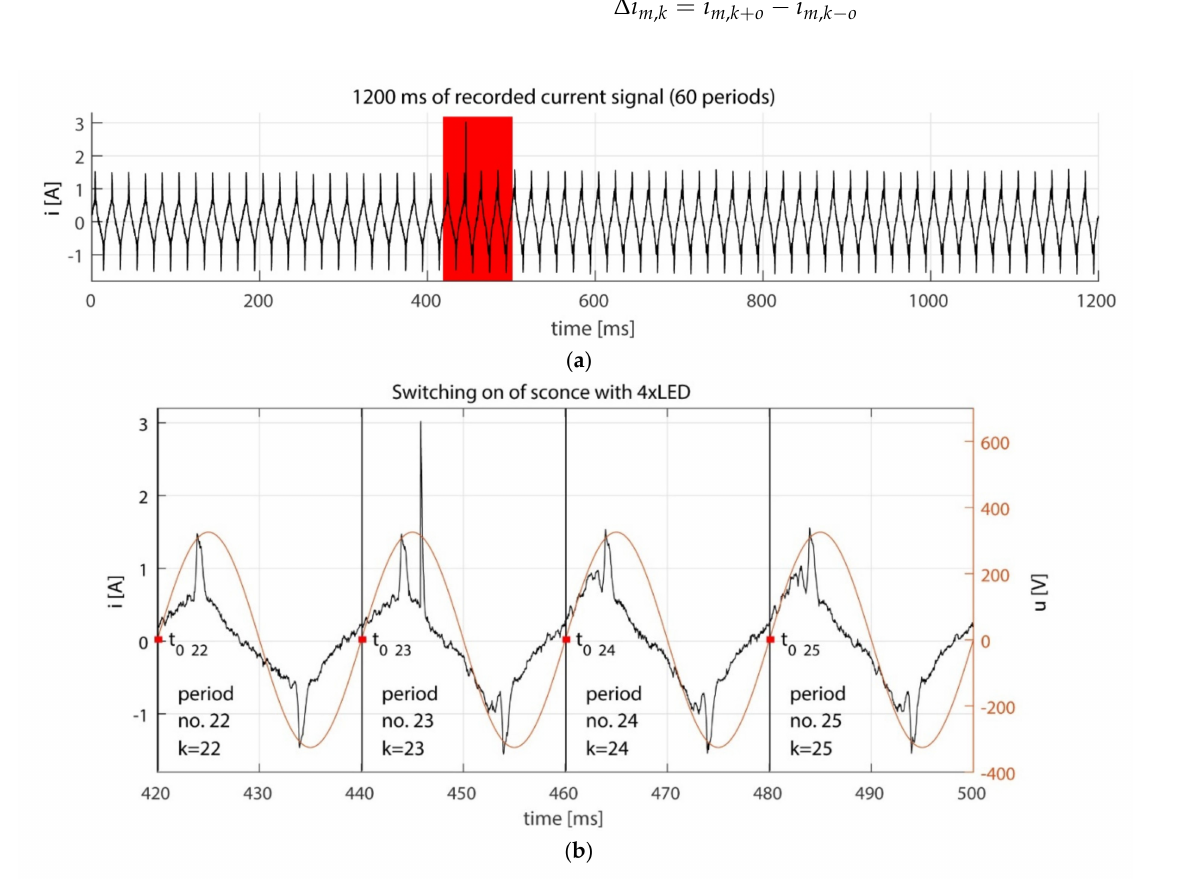
Figure 4. An example of a recorded current signal and filtered voltage u f ( a ). During recording, a wall lamp with 4 LED lamps was turned on ( b , period no. 23).